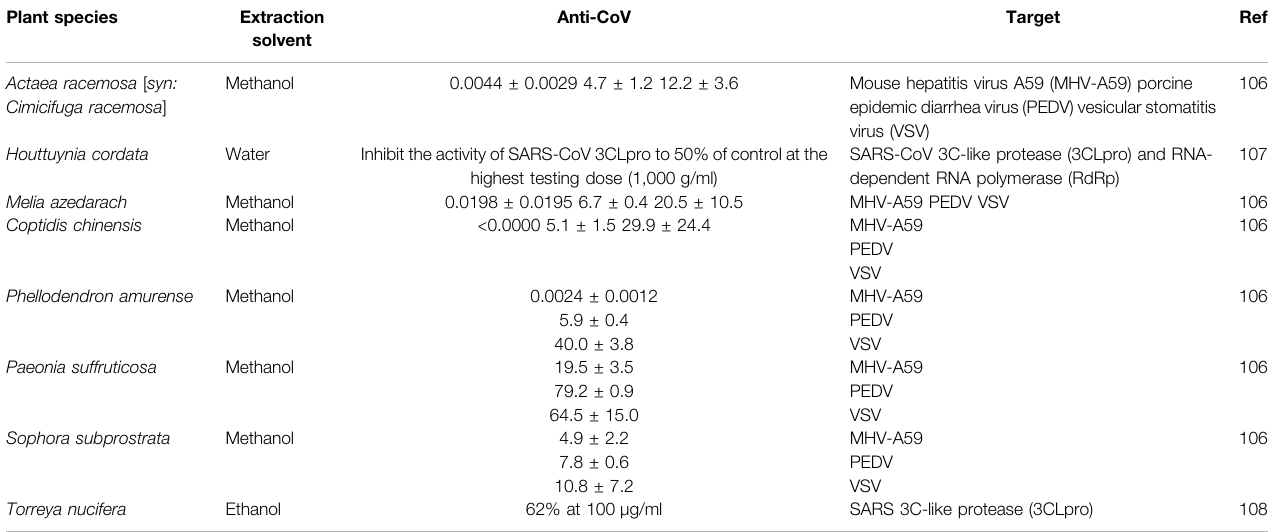
TABLE 2 | Effects of medicinal herbal extracts on coronavirus. Plant